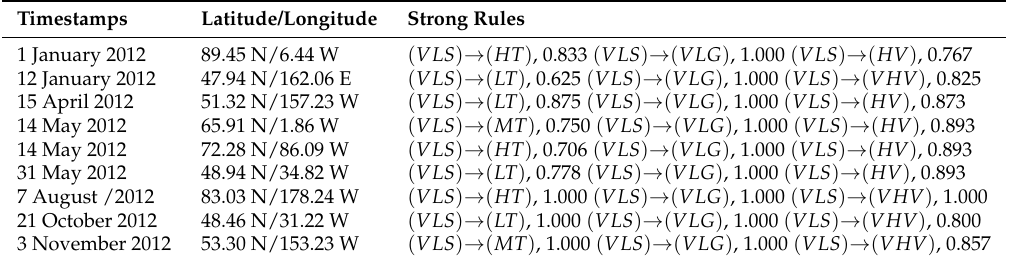
Table 1. Strong association rules that are generated near the cyclone eye in 2012; VLS, LS, MS, HS, and VHS represent very low, low, medium, high, and very high speed,